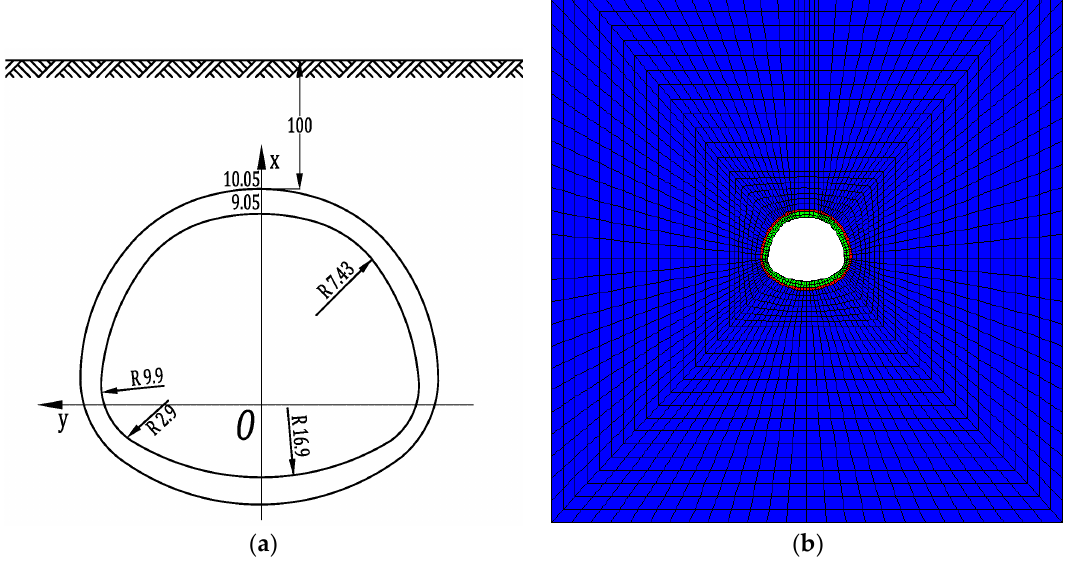
Figure 2. ( a ) Tunnel distribution diagram (Unit: m) and ( b ) Finite mesh calculation model. Table 1. Main physical parameter for tunnel calculation.